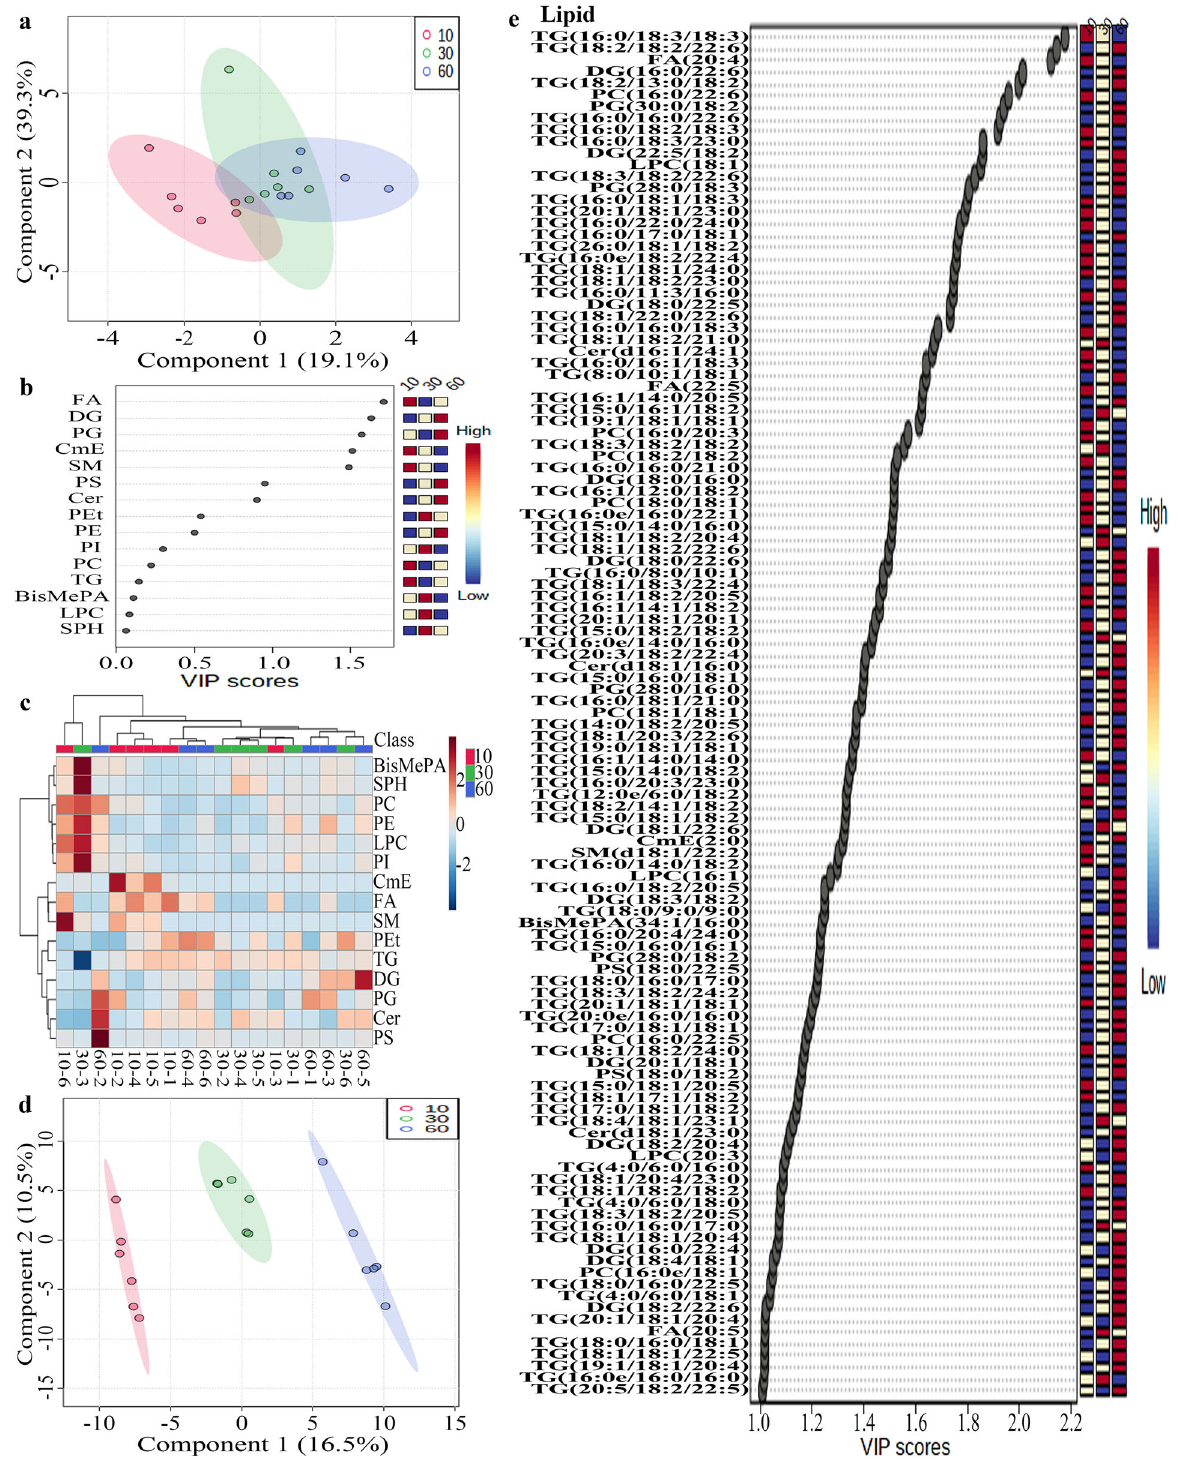
Fig. 3 Statistical analyses of lipids in tilapia juice at different steaming times by Metaboanalyst 5.0 online software according to the normalized MS data. a PLS-DA score plot of lipid classes. b VIP scores of lipid classes in PLS-DA. c Heat map of lipid classes. d PLS-DA score plot of individual lipids. e VIP scores of individual lipids in PLS-DA. The colored boxes on the right of VIP score images indicate the relative peak area of the corresponding lipid classes. Each colored cell in the heat map corresponds to a peak area value of the lipid classes on the right side. In the colored cells, red color is high and blue color is